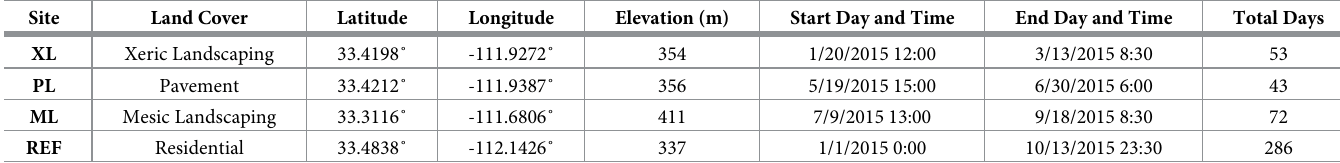
Table 1. General characteristics of the four study sites and sampling periods.